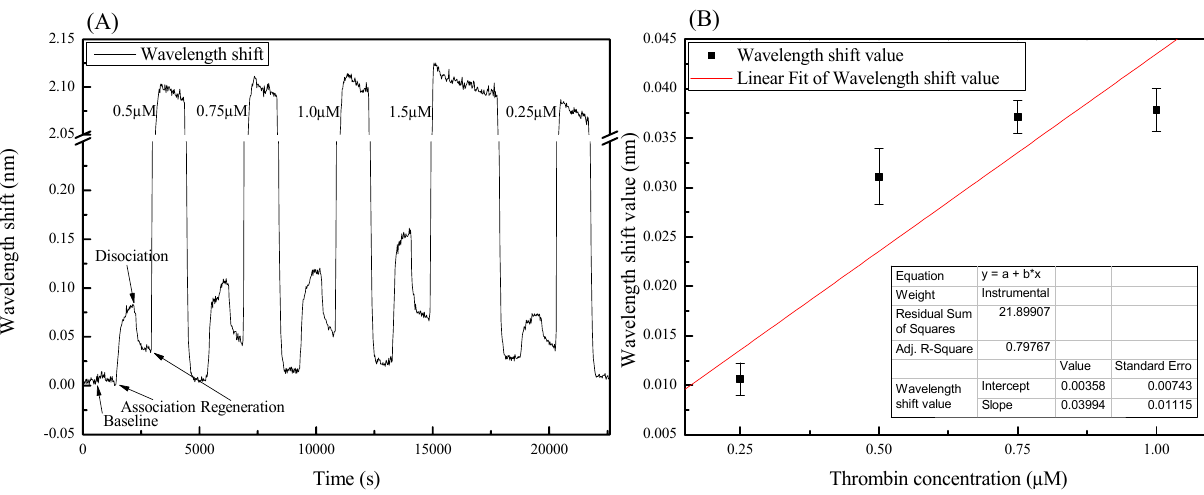
Figure 5. ( A ) Real-time sensorgram. The resonance wavelength shifted with different concentrations of thrombin. There were four steps in the detection process: first, pure tris-HCl buffer solution (baseline); second, buffer solution with thrombin (association); third, pure buffer again (dissociation); fourth, 2 M NaCl solution (regeneration). The four steps were repeated with different thrombin concentrations (0.25, 0.5, 0.75, 1, and 1.5 μ M). ( B ) The resonance wavelength responses (shifts) of the GMR sensor to different concentrations of thrombin (form 0.25 to 1 μ M). The error bars stand for the measurement noise which calculated from each baseline. The value of R 2 is 0.8 and the sensitivity is calculated to be 0.04 nm/ μ